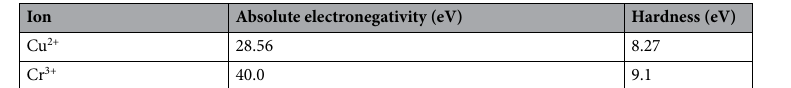
Ion Absolute electronegativity (eV) Hardness (eV) Cu 2+ 28.56 8.27 Cr 3+ 40.0 Table 3. Absolute electronegativity and hardness of the copper (II) and chromium (III) ions.